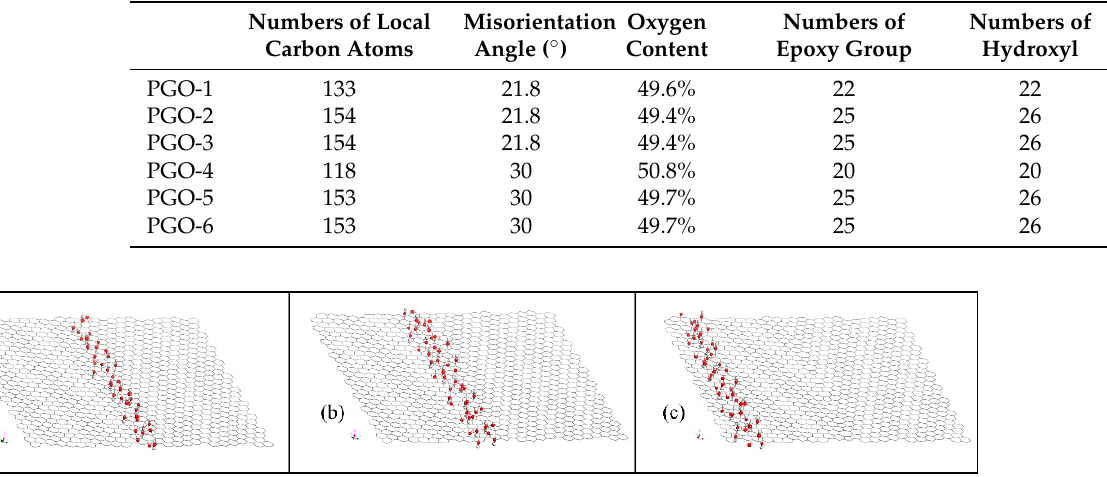
Figure 13. Structure diagram of PGO model with different functional group distribution. ( a ) distributed on GB; ( b ) distributed at the edge of GB; ( c ) distributed away from GB.